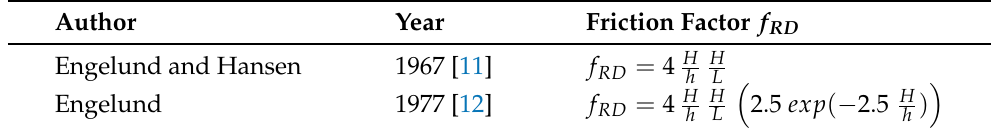
Figure 3. Check of the effects of simplification of Equation (14) by Engelund and Hansen 1967 (red curve) and information on Engelund’s 1977 improvement term (blue) as functions of the relative roughness H / h . Table 2. Approaches via Equation (14).